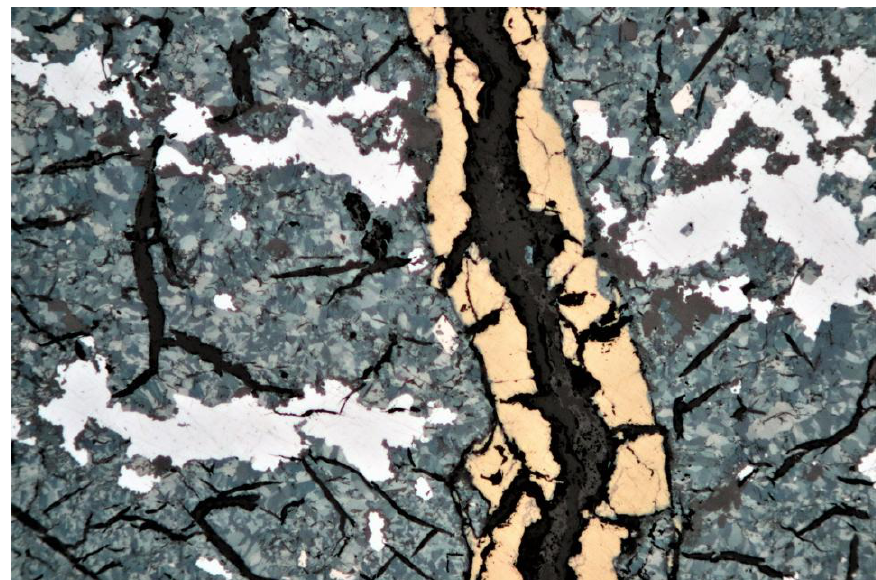
Figure 12. Brittle deformation ( d3 ) caused detachment and fragmentation of fine-grained klockmannite (blue-grey) and clausthalite (bright) perpendicular to the vein selvage and flattening of the selenides. Notably, large portions of klockmannite show finely branched shrinkage cracks (black), providing evidence for significant loss of volume. Reflected light image, 1-mm-wide, plane polarized light.